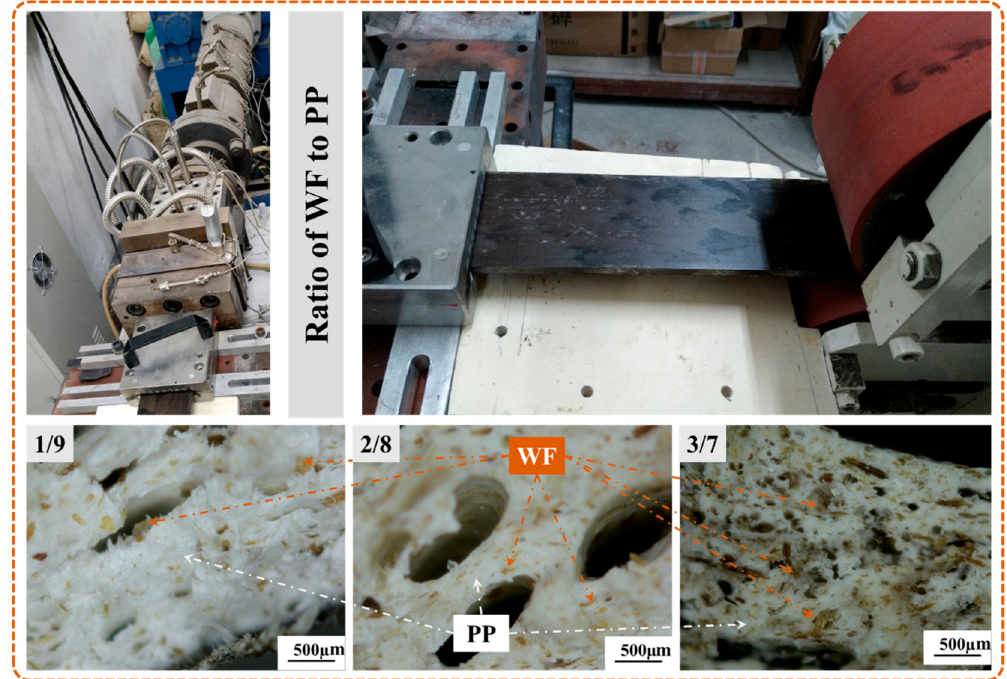
Figure 10. Dispersion state of fillers in the composites with different WF content.